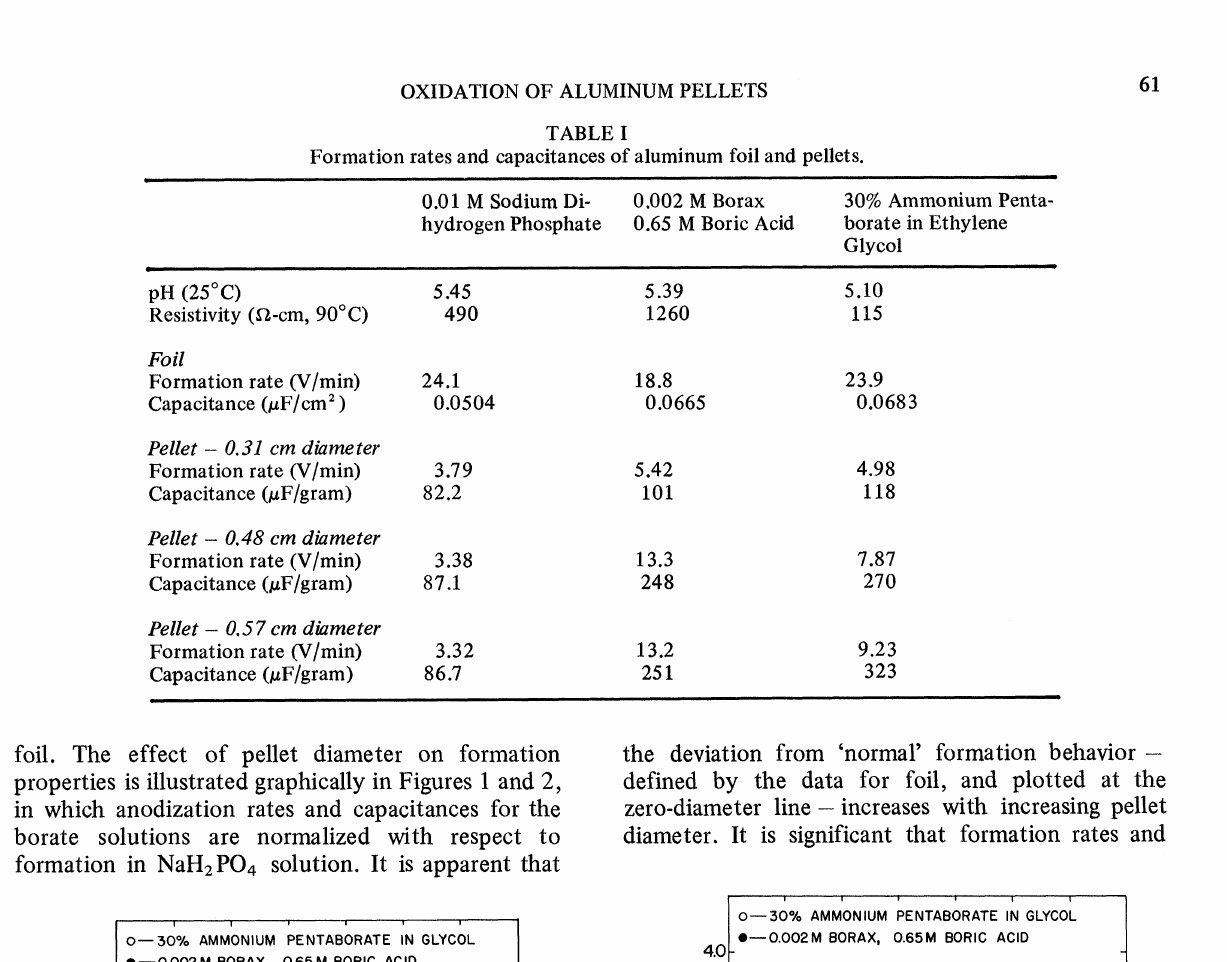
TABLE Formation rates and capacitances of aluminum foil and pellets.